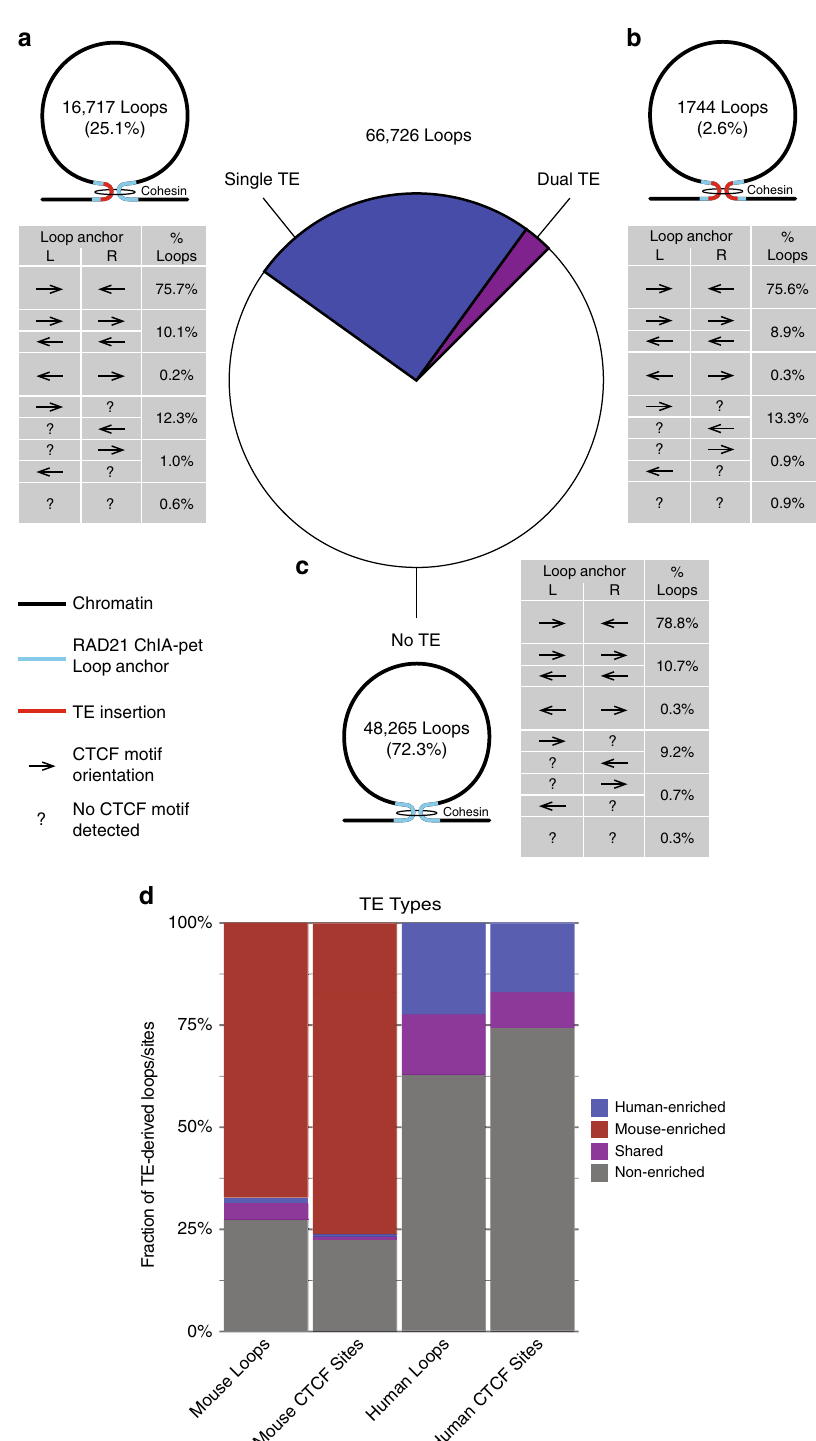
Fig. 4 Transposable elements and native CTCF-binding sites form functionally equivalent chromatin loop anchors. Human RAD21 ChIA-PET and mouse Hi-C loops containing CTCF ChIP-seq peaks at both anchors are broken down according to the number of TE-derived anchors they include. Each possible con fi guration is shown as a pictograph, with associated counts, alongside the central pie chart showing the fraction of all loops contributed by each con fi guration. Tables show the prevalence of different CTCF motif arrangements for each loop con fi guration. a Prevalence and CTCF motif arrangements for loops formed between pairs of TE-derived and native anchors. b Prevalence and CTCF motif arrangements for loops formed between pairs of TE-derived anchors. c Prevalence and CTCF motif arrangements for loops formed between anchors not derived from known TE insertions. d Contributions of CTCF- enriched and non-enriched TE types to TE-derived loops and CTCF-binding sites in human and